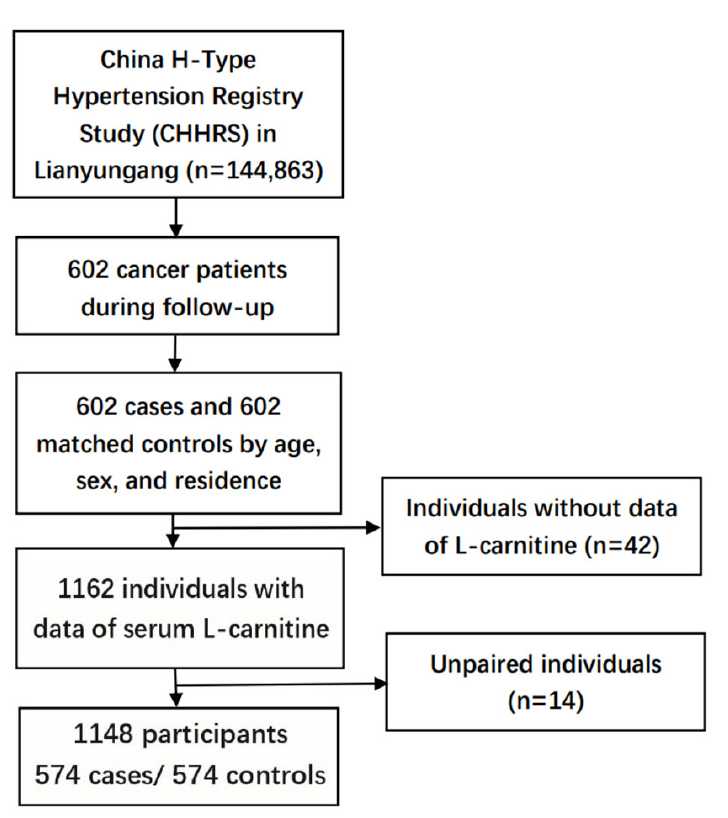
Figure 1. Flowchart of study participants in the nested case-control study within the CHHRS.